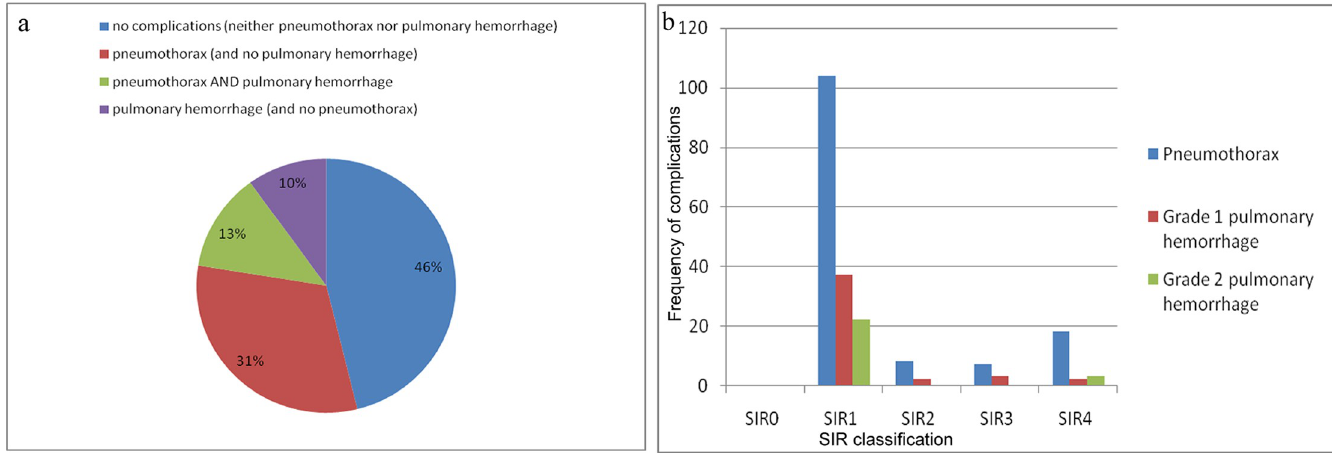
Fig 2. Complications of CT-guided lung biopsy in the study group (n = 311). ( a) Diagram of percentages of complications. (b) Diagram of frequency of complications in relation to SIR classification.